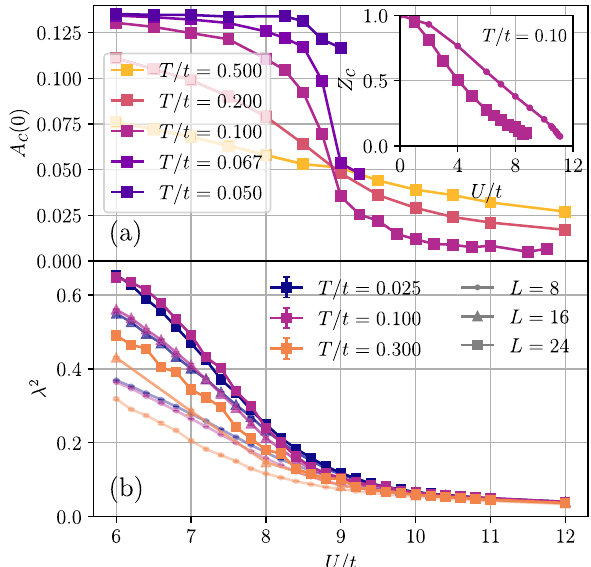
FIG. 1. Metal-insulator crossover at finite temperature from CDMFT and METTS. (a) Spectral weight at the Fermi level from CDMFT. The inset shows the quasiparticle renormalization factor for the central site in CDMFT (squares) as well as for PM- restricted DMFT (dots). A drop of the spectral weight at the Fermi level is observed. (b) Normalized localization length as a function of temperature and system size as obtained from METTS on the YC4 cylinder. Simulations have been performed 4000 . The normalized with maximal bond dimension D max ¼ localization length attains a finite value in the insulating regime and increases in the linear system size L in the metallic regime, where higher temperatures decrease the localization